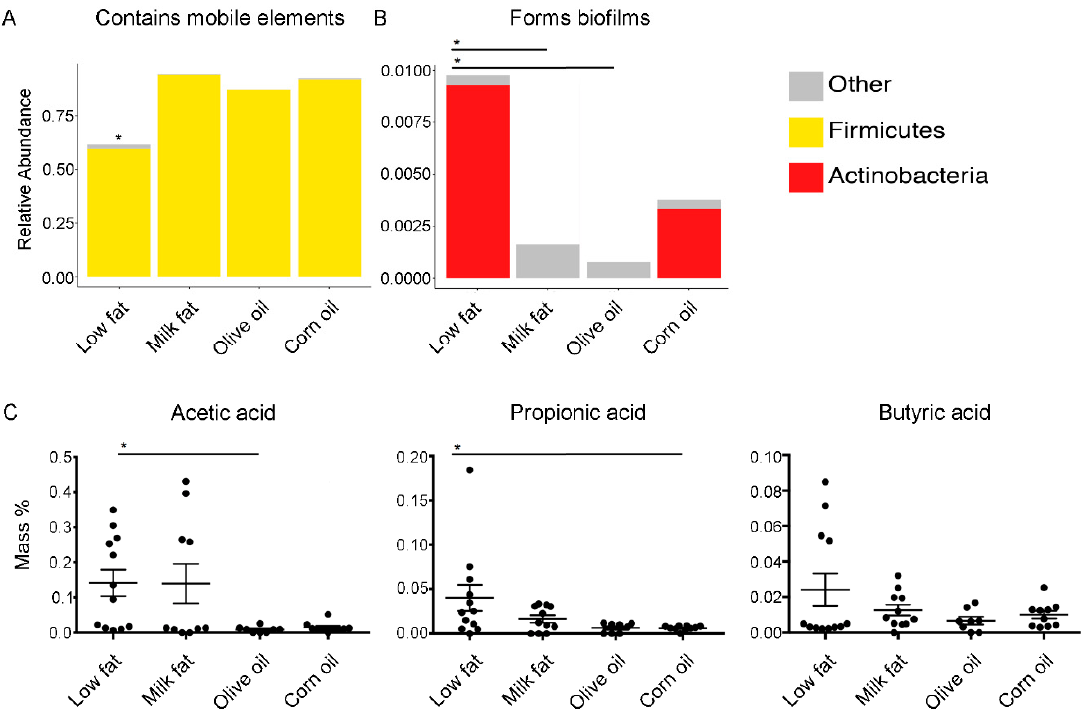
Figure 4. Predicted bacterial virulence traits and quantified secondary metabolites. Virulence traits such as ( A ) the relative abundance of bacteria which contain mobile elements and ( B ) the relative abundance of bacteria which are able to form biofilms are displayed for each diet group. ( C ) The effect of lipid diets on short-chain fatty acid production. Short-chain fatty acid analysis performed via gas chromatography on cecal samples from mice fed high-fat diets composed of milk fat, olive oil, corn oil or a low-fat chow. Acetic, propionic, and butyric acid are expressed as mass % of total cecal tissue sample. Values are expressed as mean +/ − SEM (n = 8–12). An asterisk above a single column indicates P < 0.05 for that group compared to every other dietary group. An asterisk with a line connecting two groups indicates P < 0.05 between the two